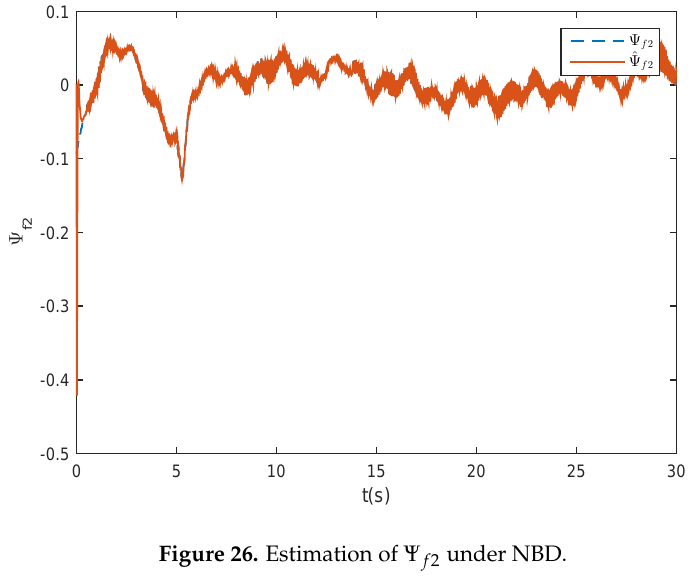
Figure 26. Estimation of Ψ f 2 under NBD.